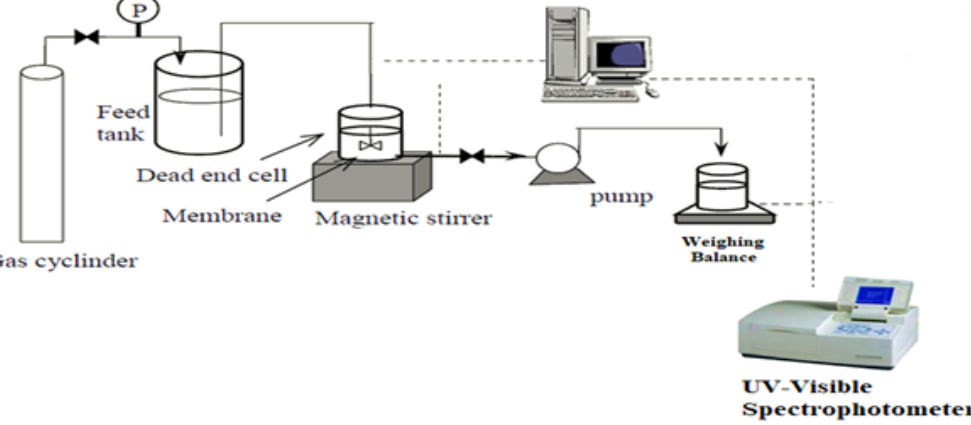
Figure 2. Dead end filtration assembly to check permeation flux and absorbance.